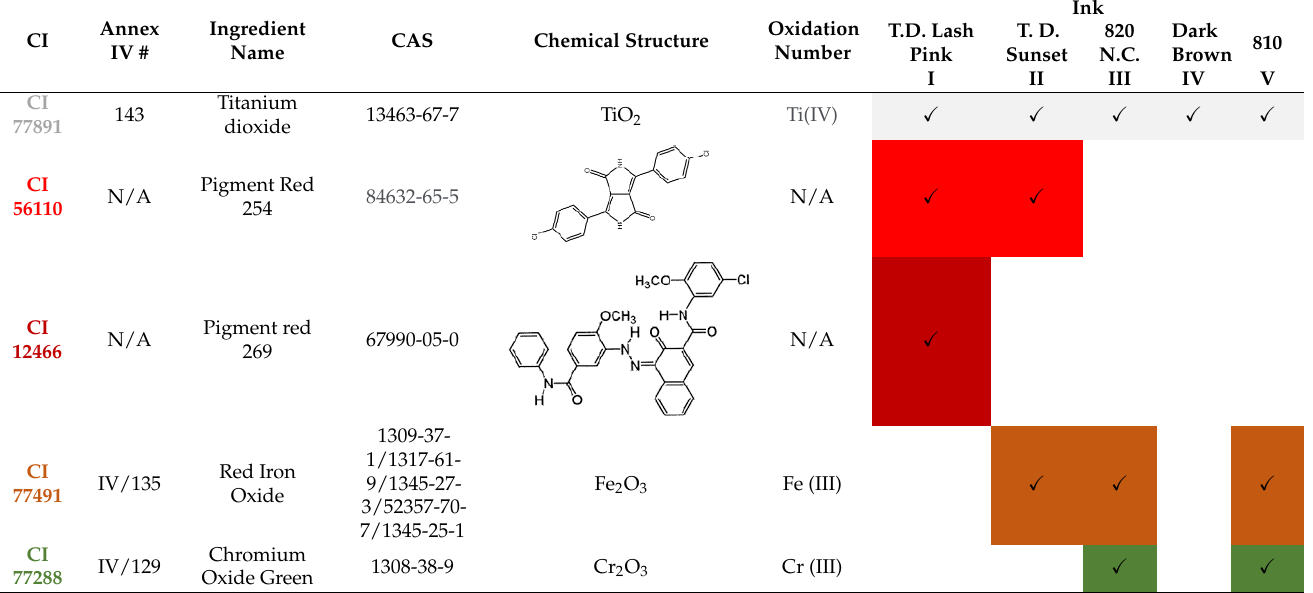
Table 1. Colorant ingredients of the tested PMU inks.